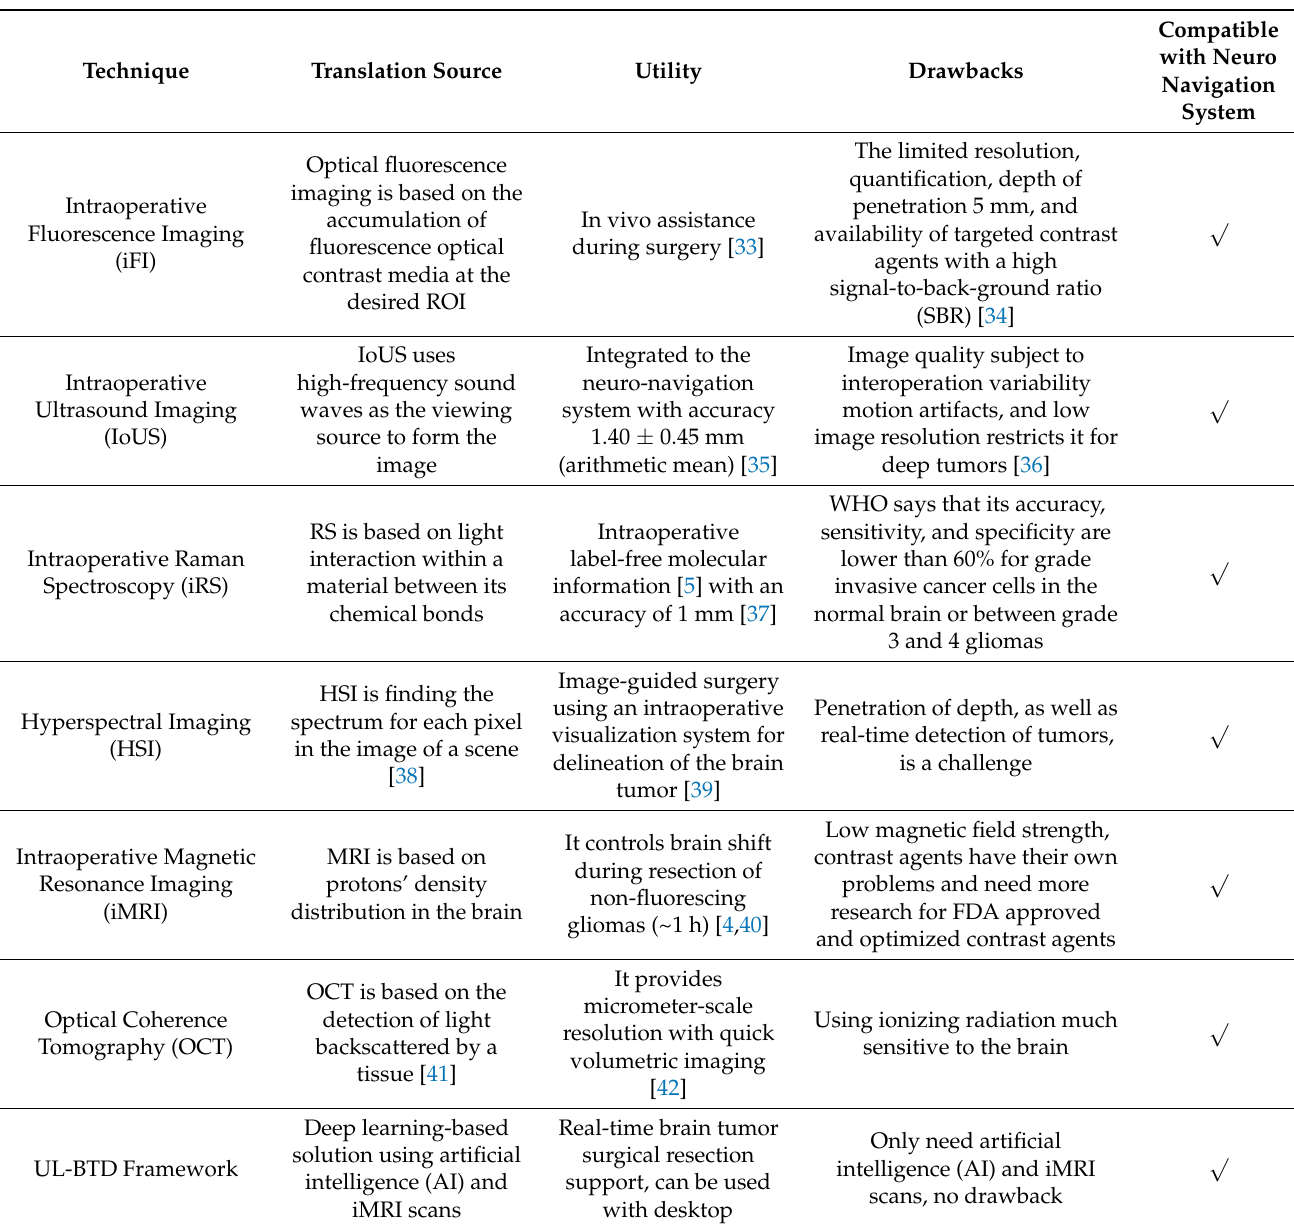
Table 11. Comparison of different intraoperative neurosurgical navigation systems with the proposed